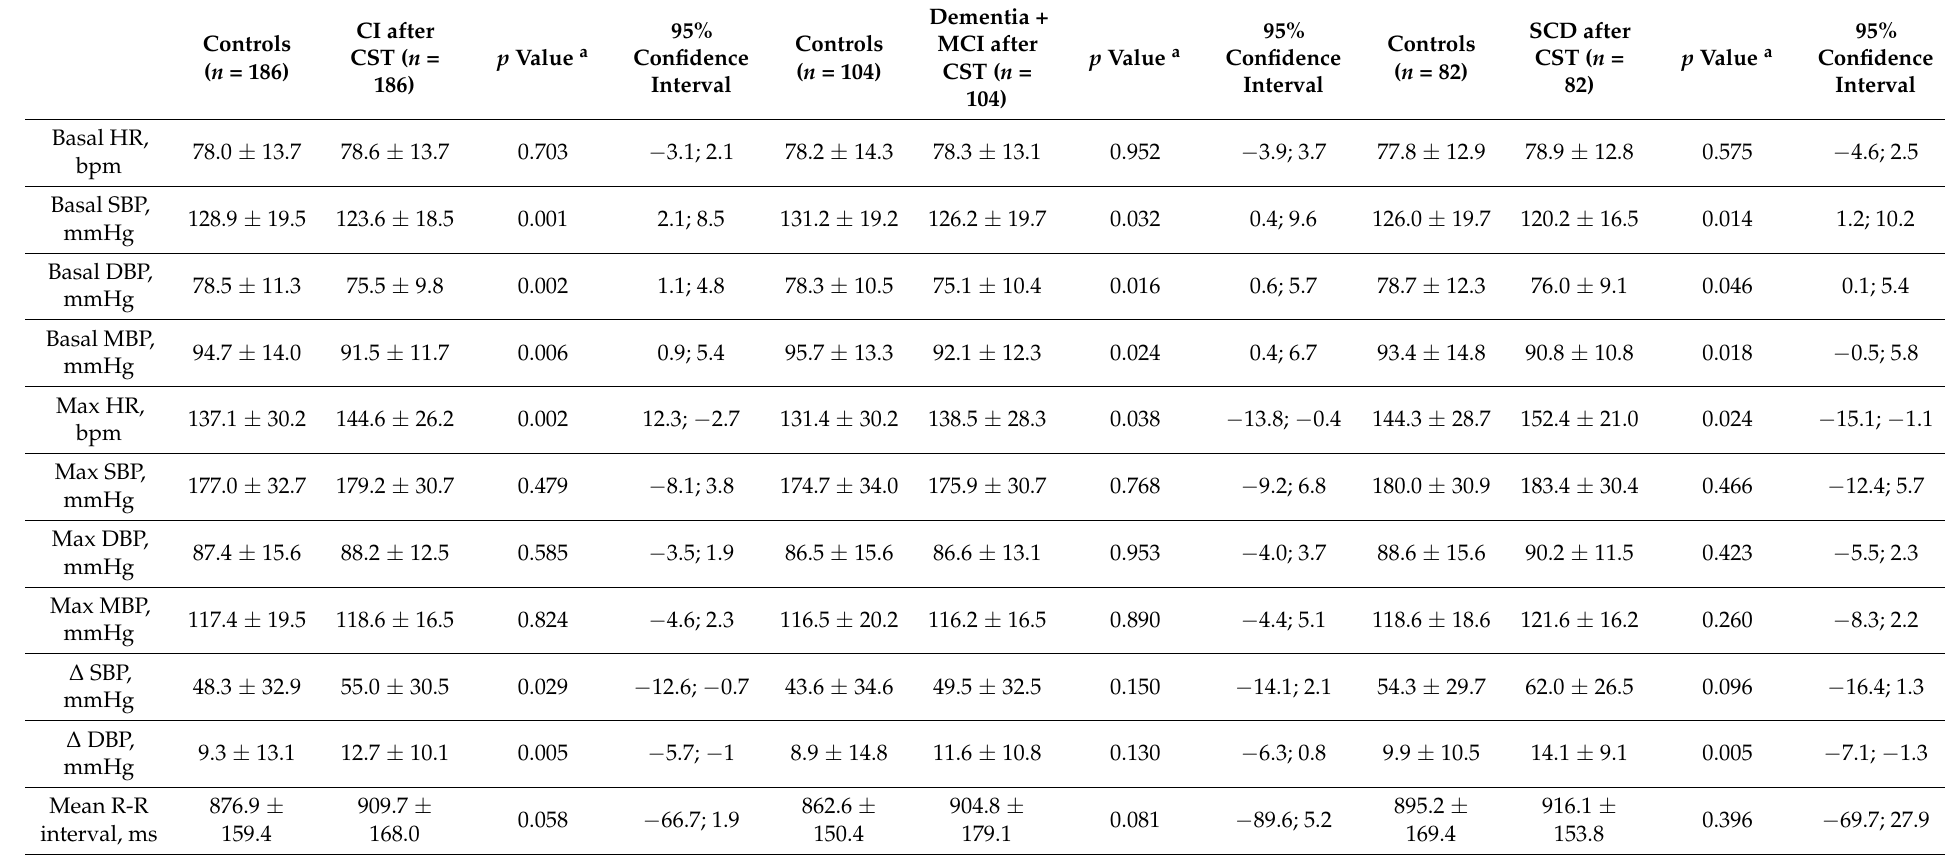
Table 2. Cardiac stress test and heart rate variability measures overall and by